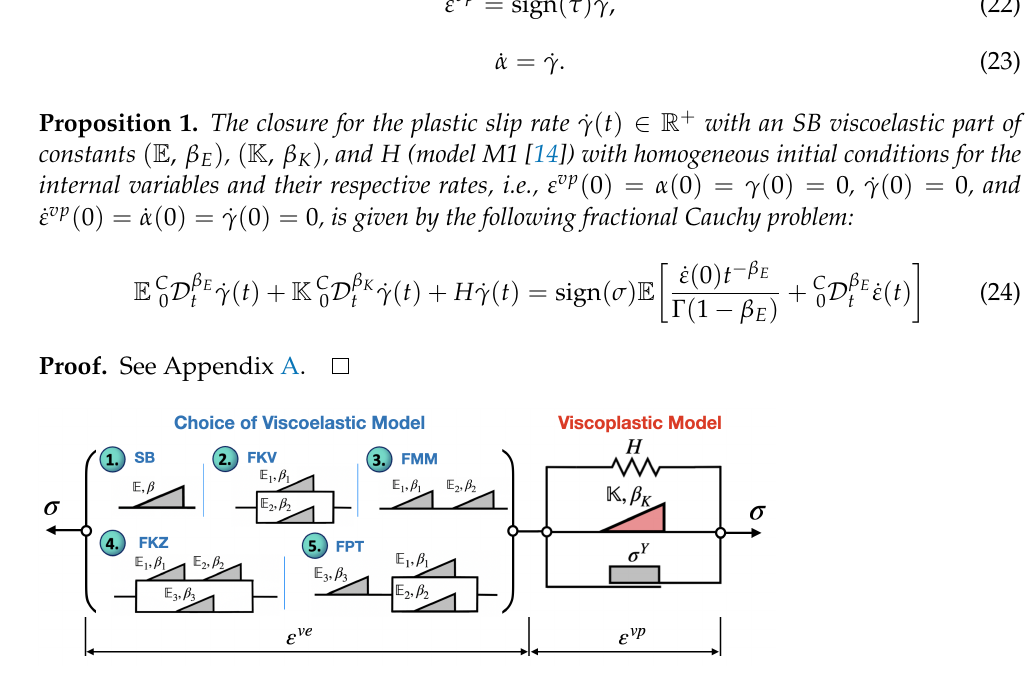
Figure 2. Fractional visco-elasto-plastic model subject to a uniaxial stress σ . Here, any of the linear and quasi-linear (not illustrated) fractional viscoelastic models under strains ε ve can be chosen and then coupled with a fractional viscoplastic rheological device under strains ε vp